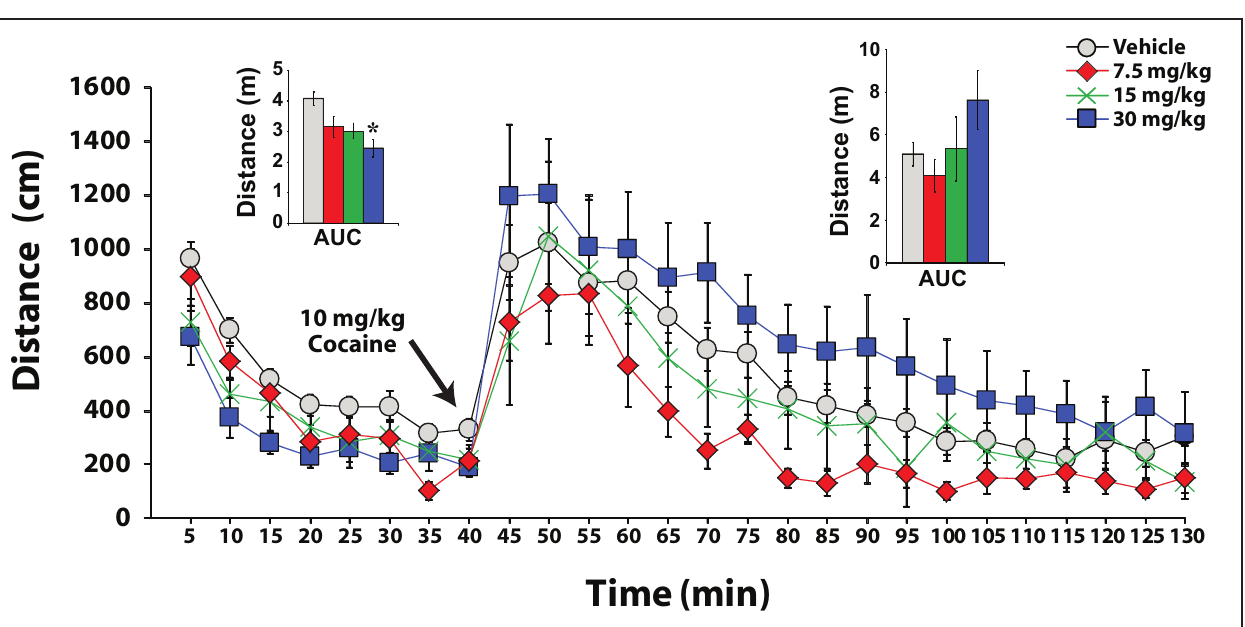
doses were reduced every 10min (for clarity only every other dose is shown). Note that the rate of responding increases as the dose of cocaine is lowered and eventually rats cease responding for cocaine. During the early portions of the session, SB-334867 has no effect on consumption, however, SB-334867 reduced the dose at which rats ceased responding for cocaine. Modified from España et al. (2010).